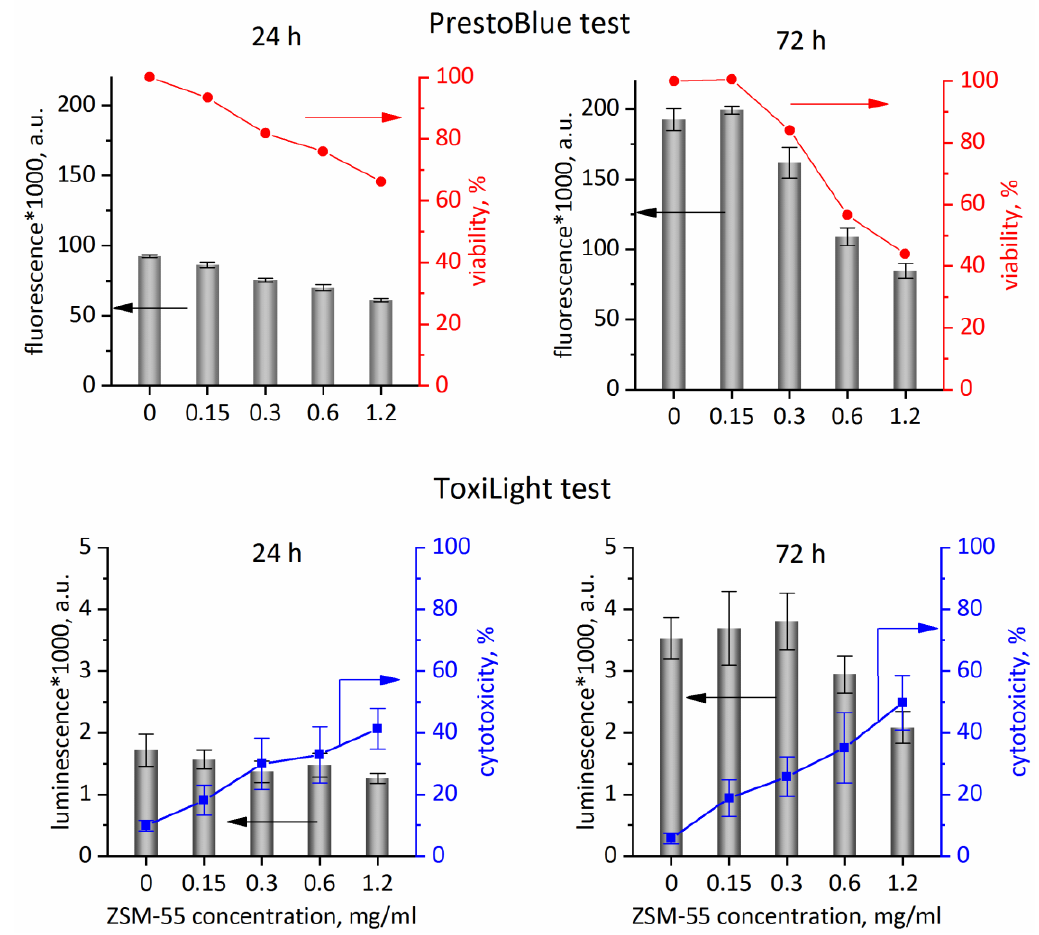
Figure 8. Upper panes: Viability of L929 cells based on the PrestoBlue test: dependence of fluorescence intensity (in relative fluorescence units) on material concentration after 24 h and 72 h of incubation of ZSM-55 material. Lower panes: Proliferation based on ToxiLight test results: luminescence related to concentration of living cells (bars) and cytotoxicity (lines) dependence on the concentration of ZSM-55 after 24 h and 72 h of incubation.